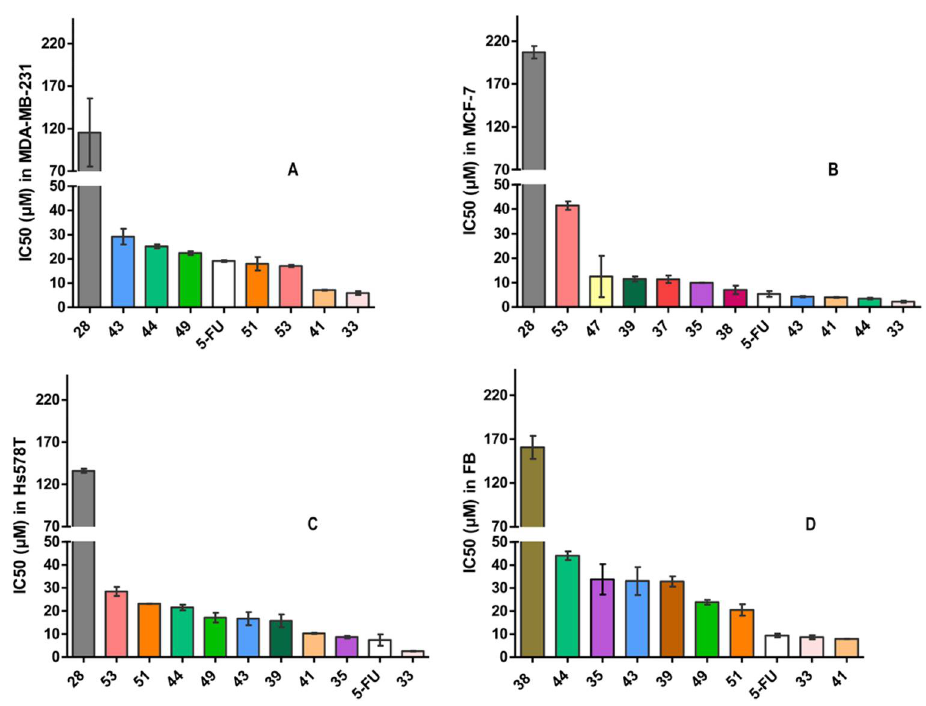
Figure 4. IC 50 values of the most potent compounds and 5-FU (positive control) against each cancer cell line; ( A ) MDA-MB-231; ( B ) MCF-7; ( C ) Hs578T; and ( D ) against normal primary FB.